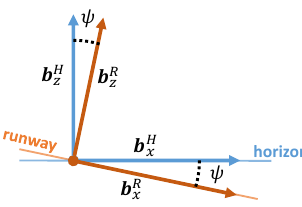
Figure 2. Reference frames: horizon and runway. Definition of ψ